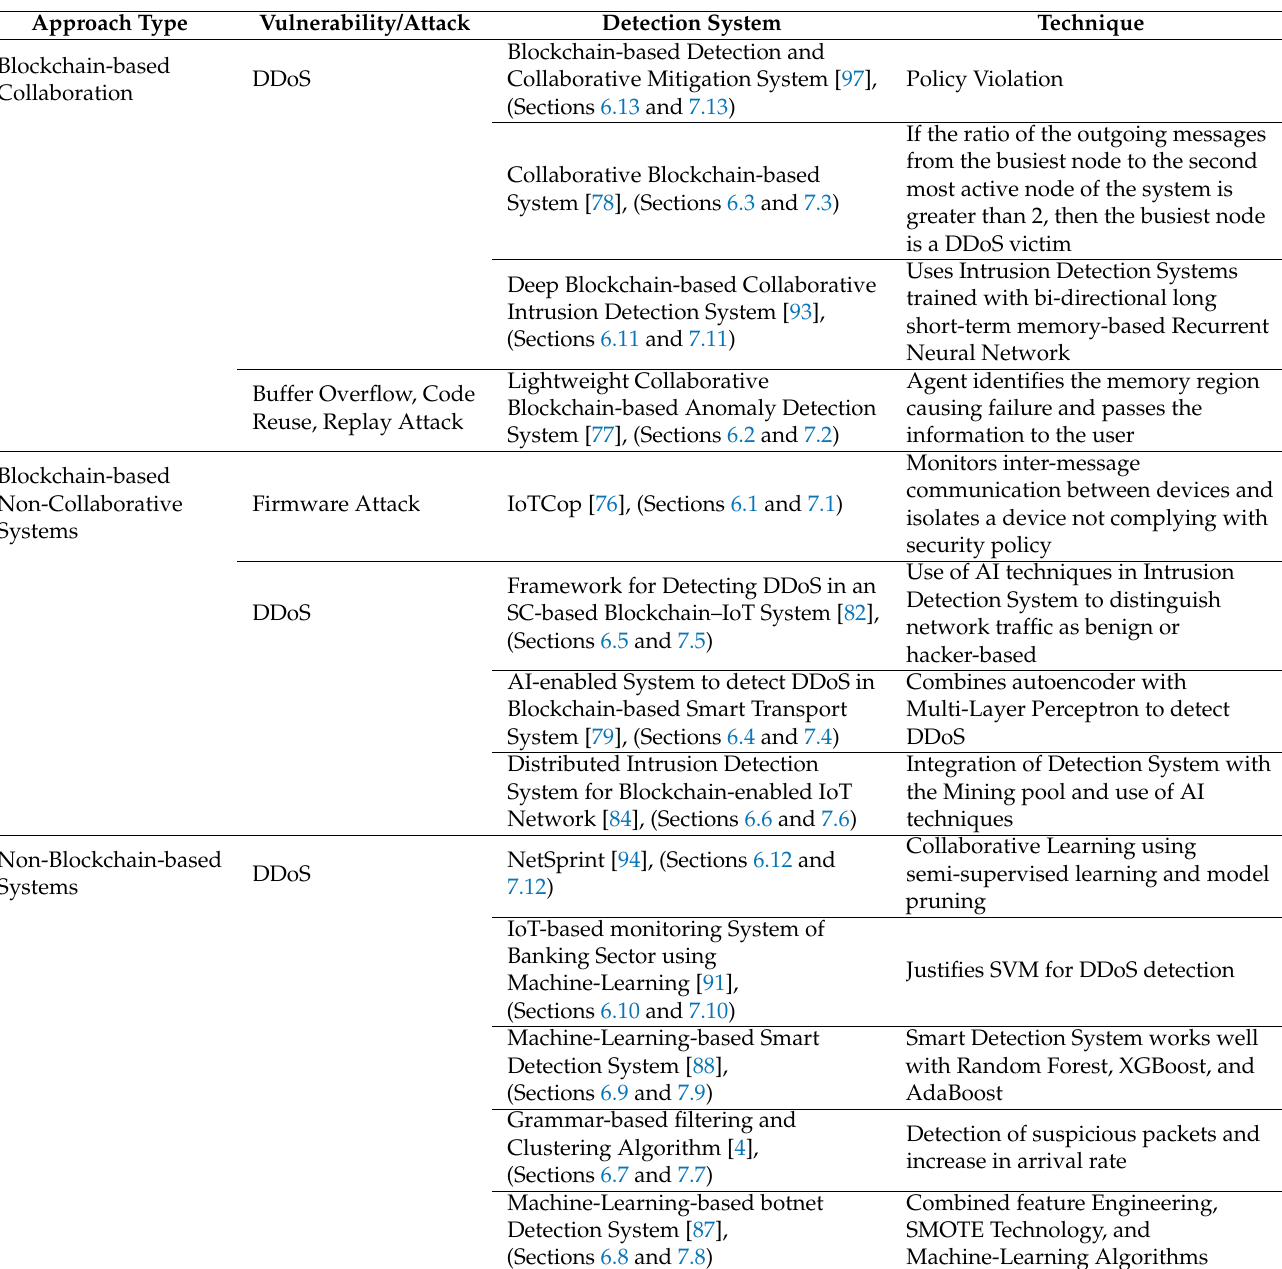
Table 4. IoT-based Firmware, Physical, and DDoS Attacks: Classification and detection